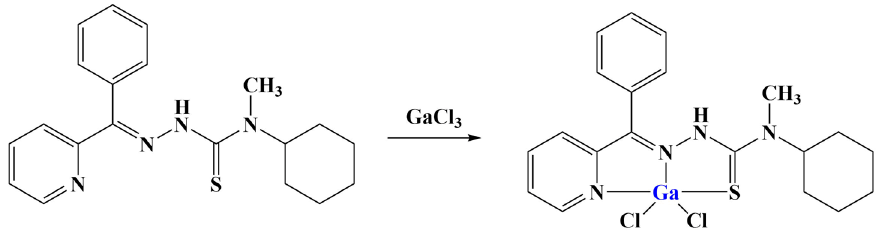
Figure 20. One of the complexes presented in [91].